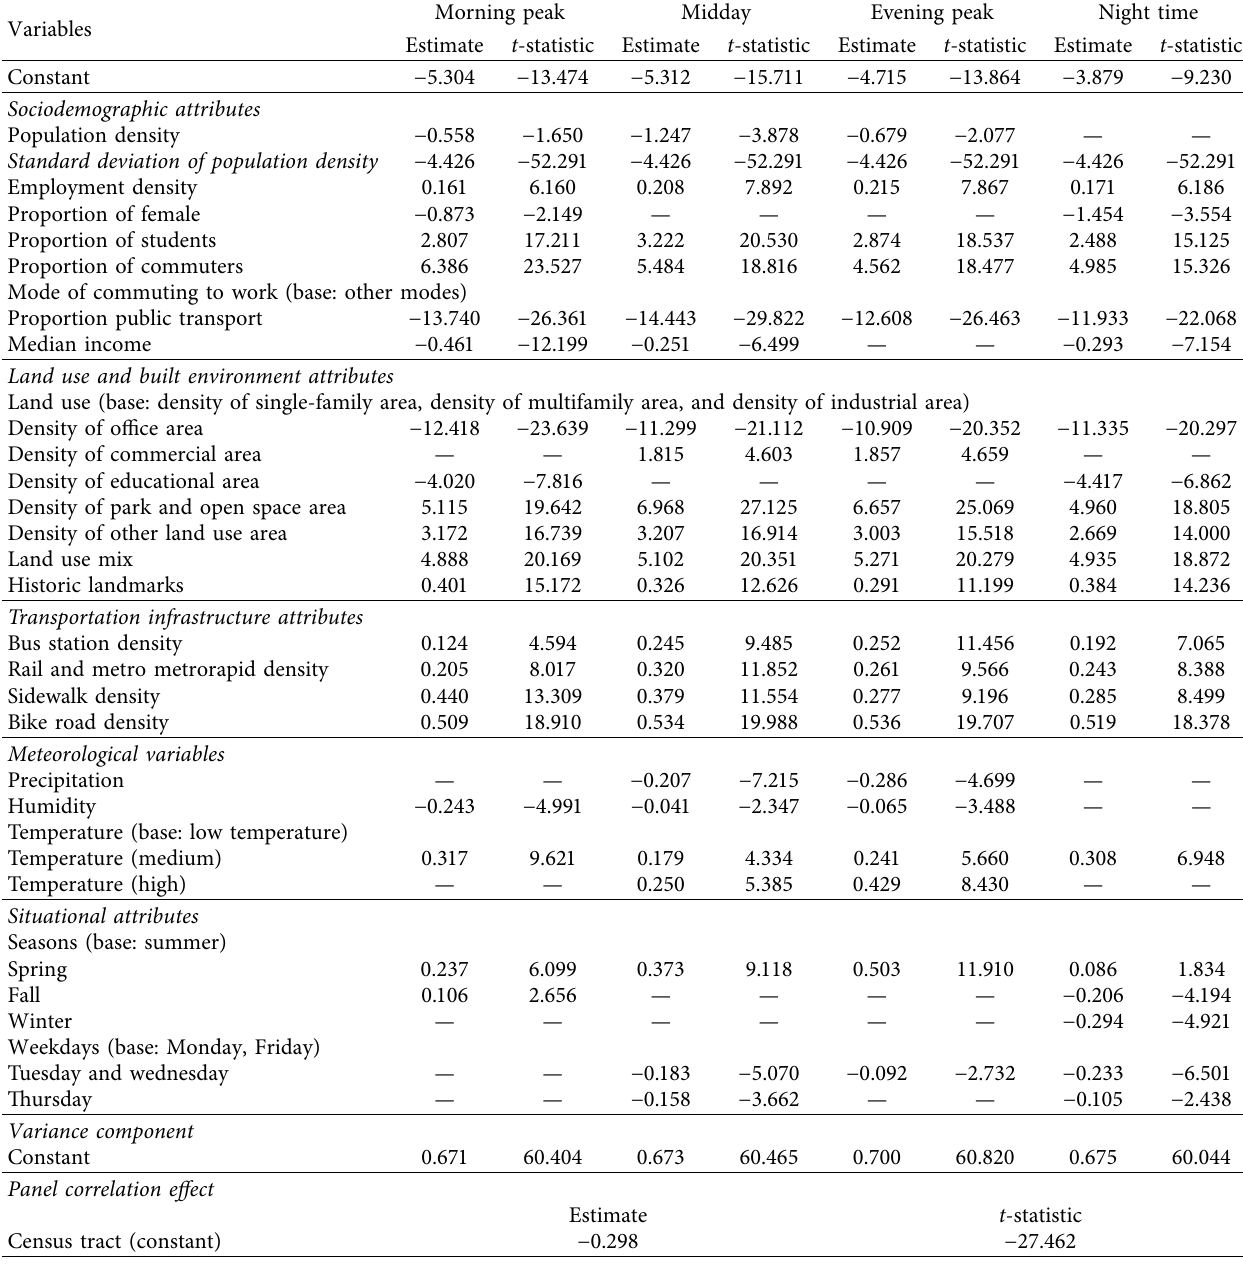
Table 2: Panel linear regression model results for